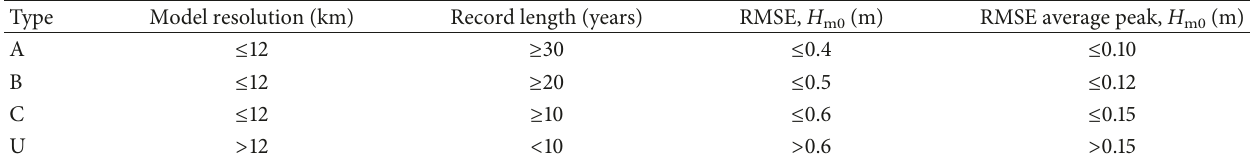
Table 6: Model performance statistics for wave models (A (cid:31) design; B (cid:31) appraisal; C (cid:31) strategy; and U (cid:31) unsatisfactory); from Defra/EA [3]. Type